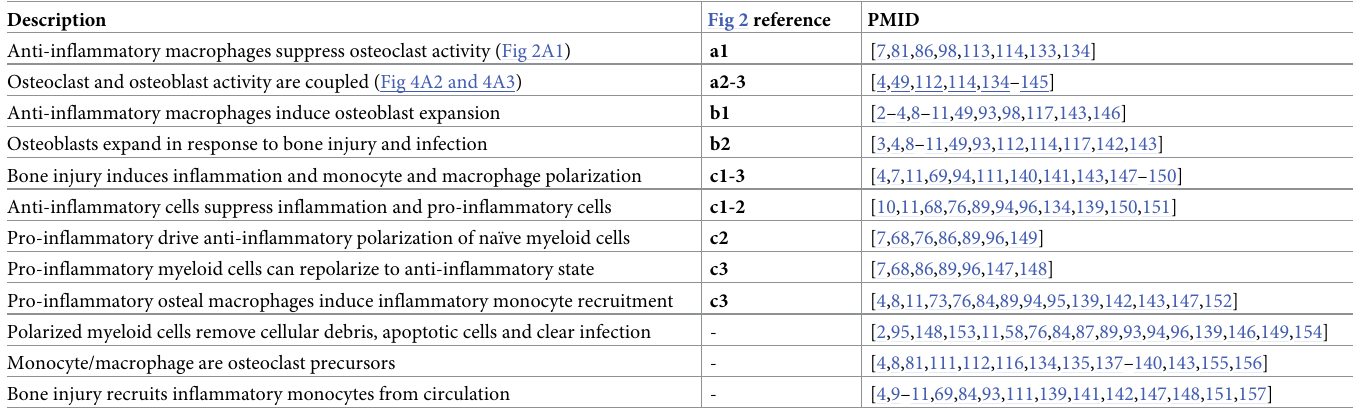
Table 1. Reference sources of predominant mechanisms. Established biological behaviors and functions of bone cell populations. Framework for a comprehensive and coupled 9-population ODE model is constructed based off of summarizing known published interactions between each population. Inclusion of select hypotheses for each ambiguous aspect of myeloid biology is based on the prevalence of their corresponding publications (at least seven supporting references for each). Description Fig 2 reference